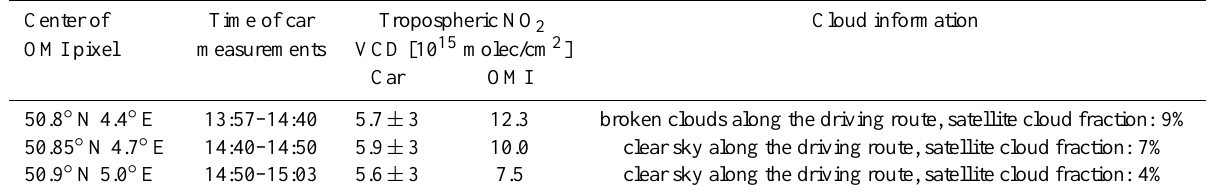
Fig. 5. Colour coded NO 2 VCDs for the Brussels-Heidelberg road measurements on 5 September 2006 (derived from the 22 ◦ elevation angle) and OMI tropospheric NO 2 VCDs for the same day (DOMINO product from TEMIS, see http://www.temis.nl/airpollution/no2.html). Table 1. Comparison of the tropospheric NO 2 VCD from Auto MAX-DOAS and OMI for the three satellite ground pixels close to Brussels (see Fig. 5). OMI data are from www.temis.nl (DOMINO). OMI overpass is at ∼ 14:40 local